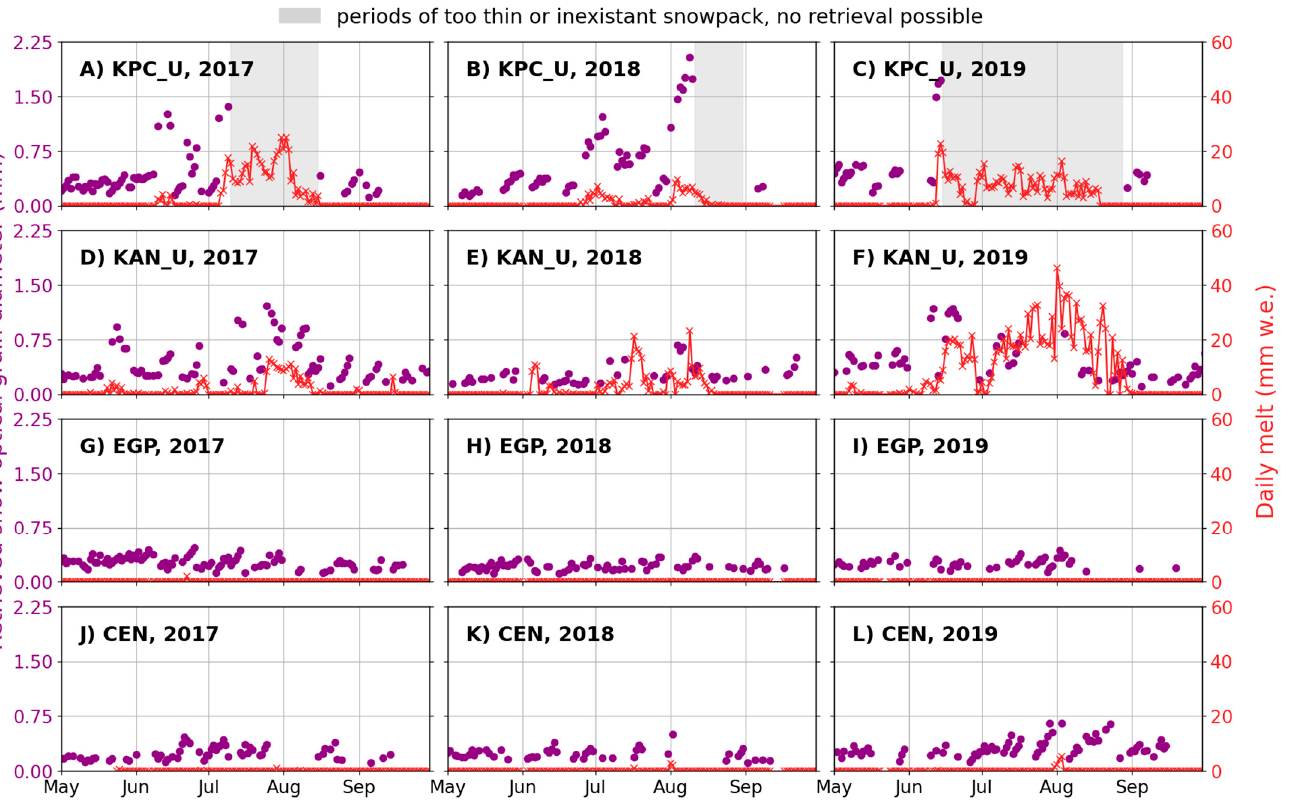
Figure 4. Retrieved snow optical grain diameter ( d opt , purple dots) and melt (red line and crosses) calculated from PROMICE AWS measurements.